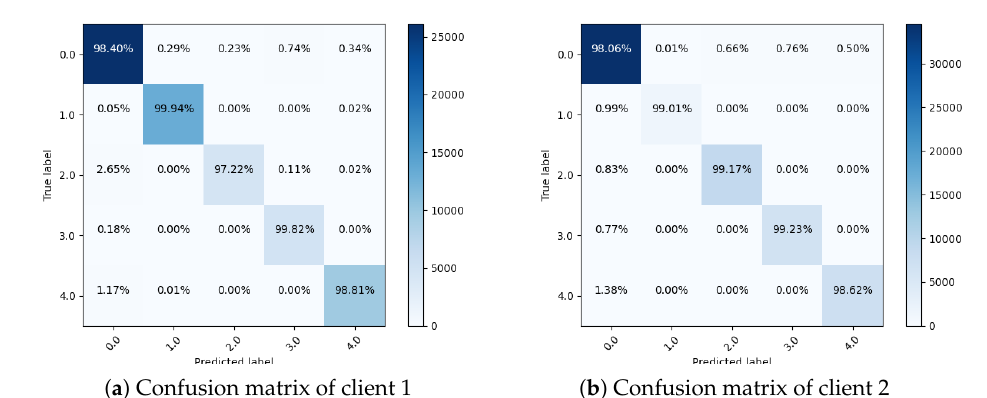
Figure 5. Confusion matrices for both clients using proposed